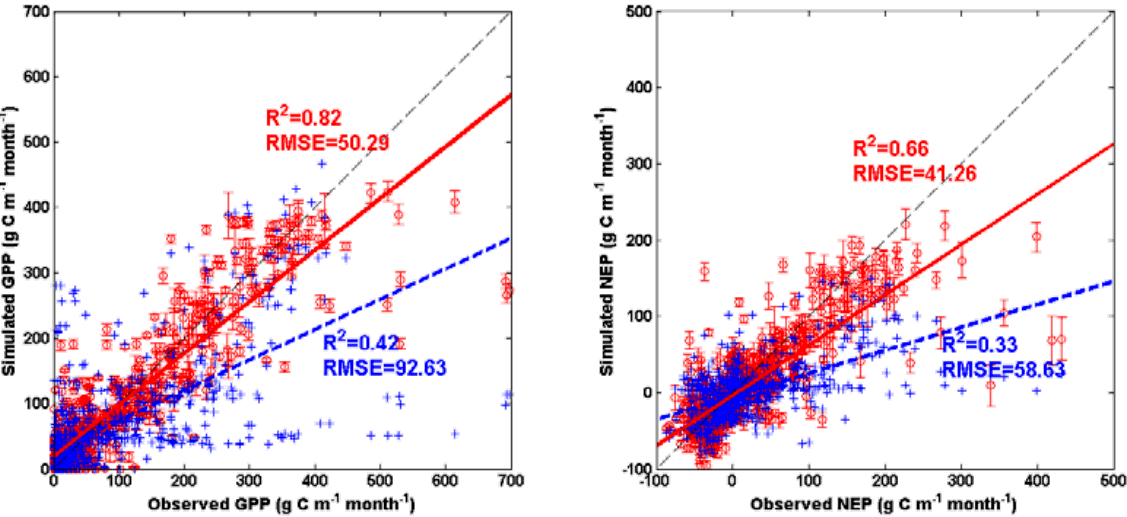
Fig. 4. Scatterplots of the observed GPP and NEP versus SAT-TEM and TEM predictions at the selected AmeriFlux sites. Black dashed lines show a 1:1 relationship. Circles and crosses, red and blue regression lines are SAT-TEM and TEM simulated values, respectively. The error bars indicates the standard deviation of the results by ensemble SAT-TEM simulations with 50 sets of posterior parameters. (a) and (b) are the predicted GPP and NEP versus observed values, respectively. Table 6. Estimated annual GPP, NPP and NEP across conterminous United States over 2000–2005. The units of the carbon fluxes are PgCyr − 1 . GPP Year